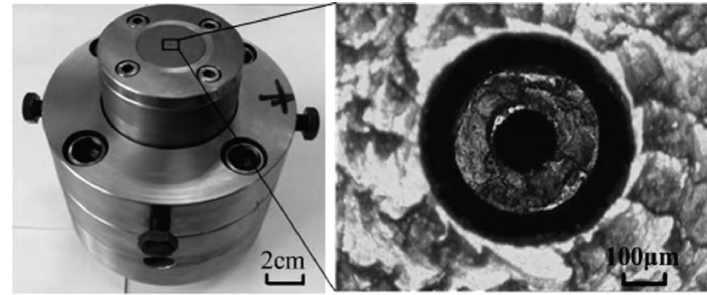
Figure 7: Single-lumen extrusion die and its